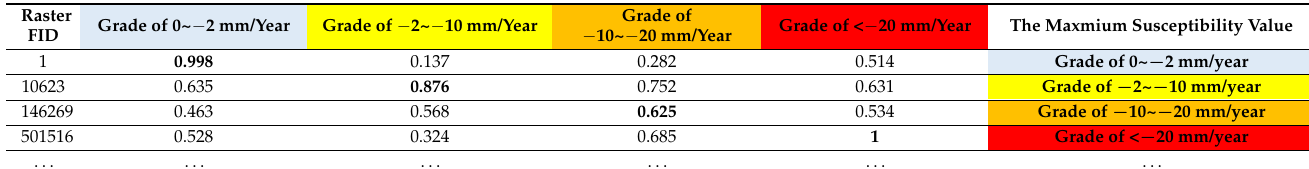
Table 5. The example of susceptibility comparison of raster land subsidence